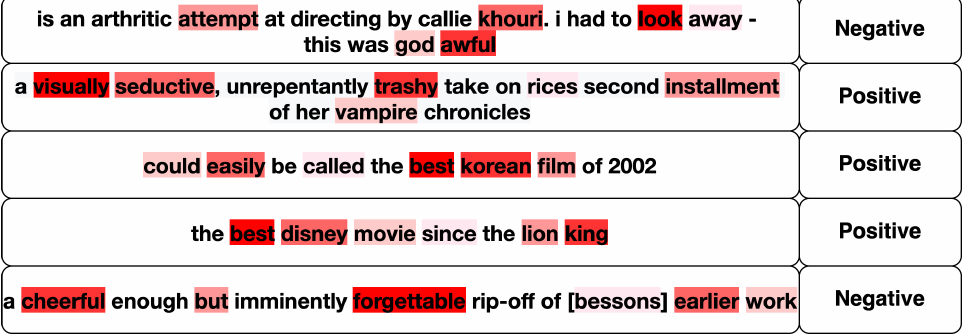
Figure 4. Visualization of attention weights with Bi-GRU and TM Score. Dark red to light red color represents the color gradients based on the attention weights in descending